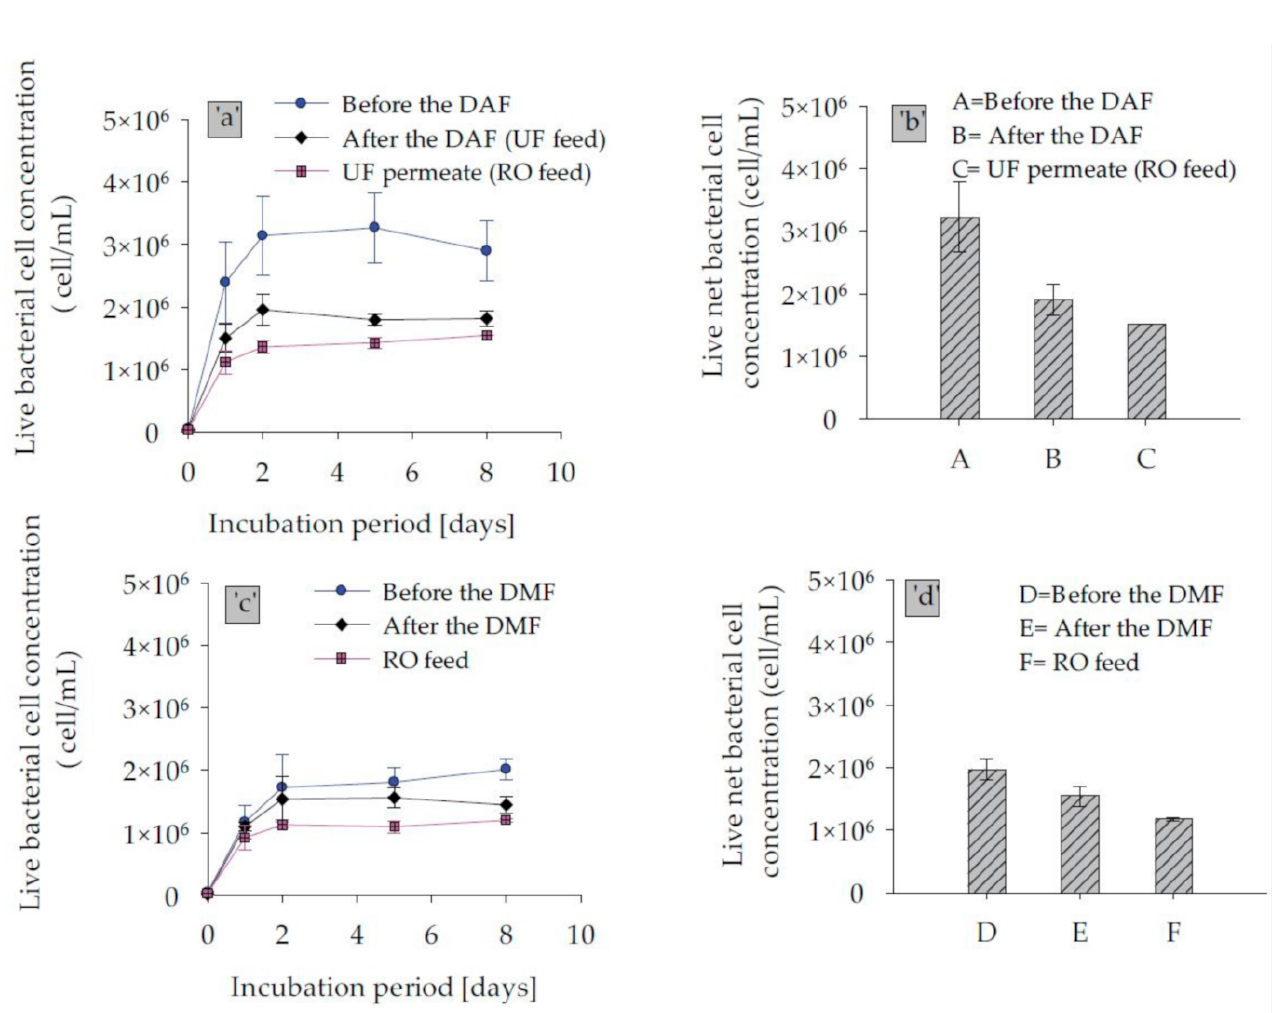
Figure 7. Live bacterial regrowth curve and calculated live net bacterial cell concentration from the growth curve for samples collected from ( a , b ) DAF–UF–RO, and ( c , d ) DMF–CF–RO treatment